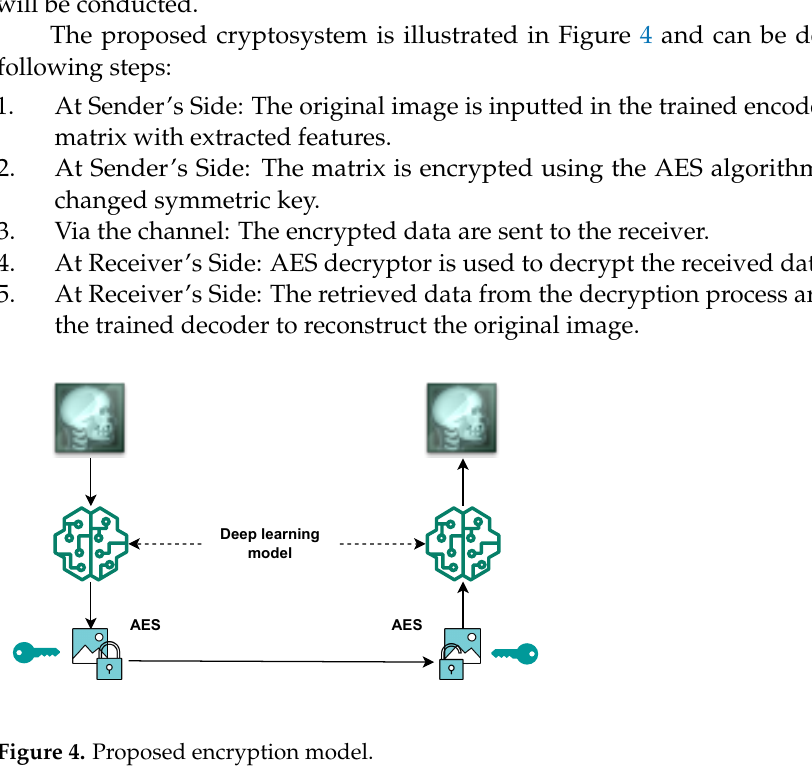
Figure 4. Proposed encryption